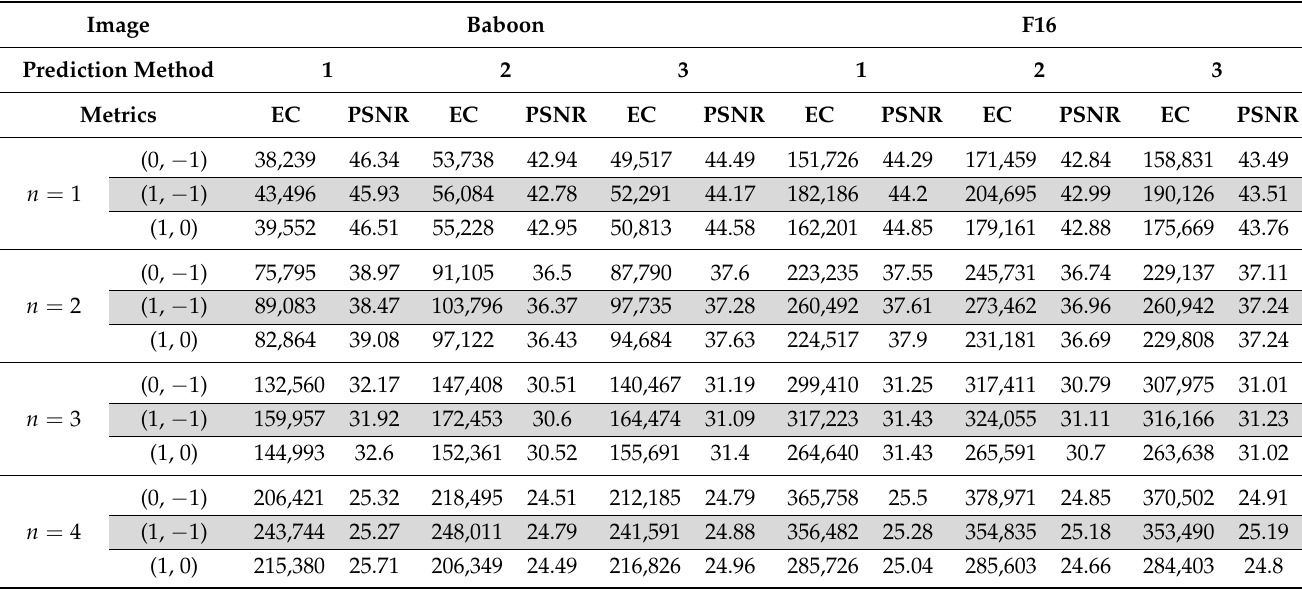
Table 6. Comparison of the performance of our triple-RDH method on images “Baboon” and “F16” with different n and different peak points.